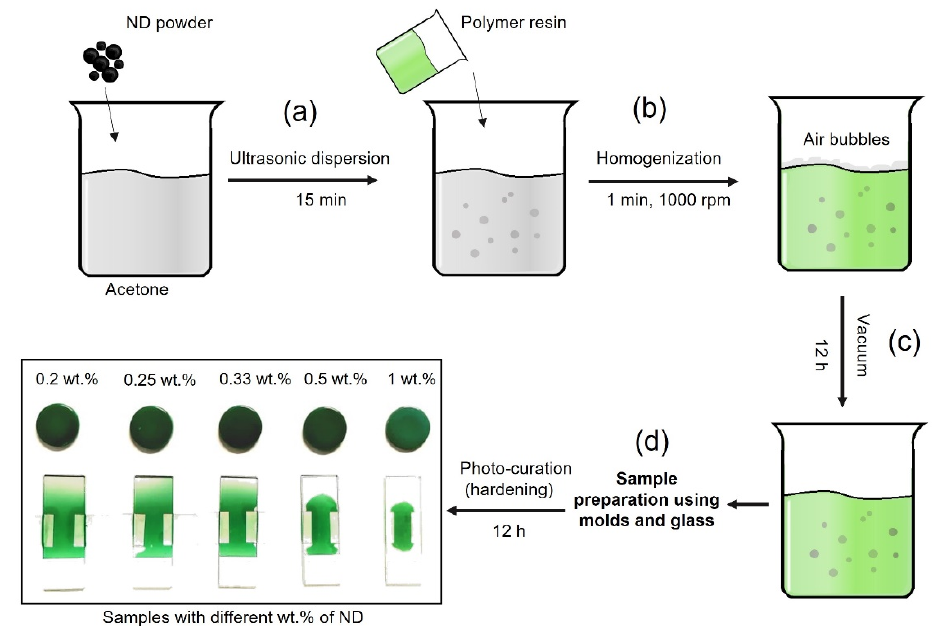
Figure 1. Schematic of the preparation of MDPs–polymer composites: dispersion of acetone and MDPs solution ( a ), homogenization of the obtained solution with polymer resin ( b ), air-bubble removal with vacuum ( c ), and photocuring of prepared samples ( d ) .